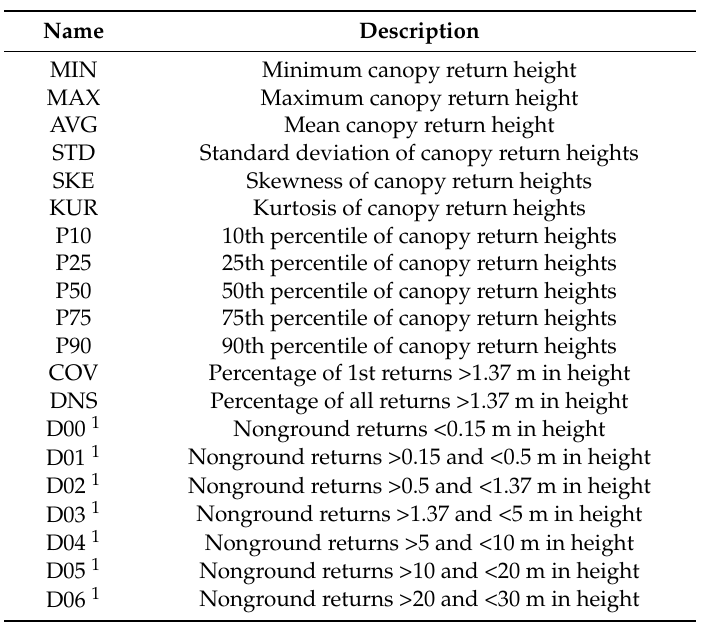
Table 1. Names and descriptions of lidar explanatory variables. Canopy returns were defined as returns >1.37 m in height. Lidar variables were candidates for predicting canopy and surface fuel variables. A total of 48 lidar explanatory variables were